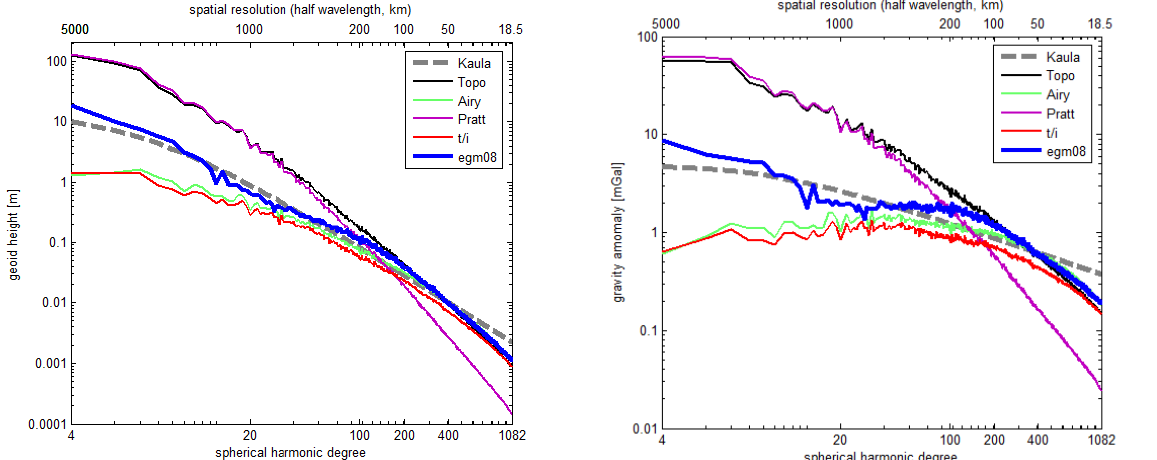
Figure 1. RMS degree variances expressed in geoid heights of the uncompensated topography (Topo), three different t/i mod- els (Airy, Pratt and t/i), combined model EGM2008 and Kaula’s rule. Unit is m.